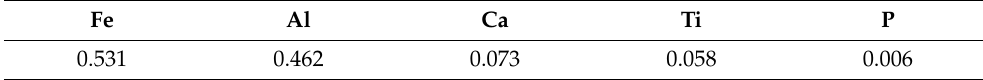
Table 1. Contents of impurity elements in metallurgical-grade silicon for experiments, wt%. Fe Al